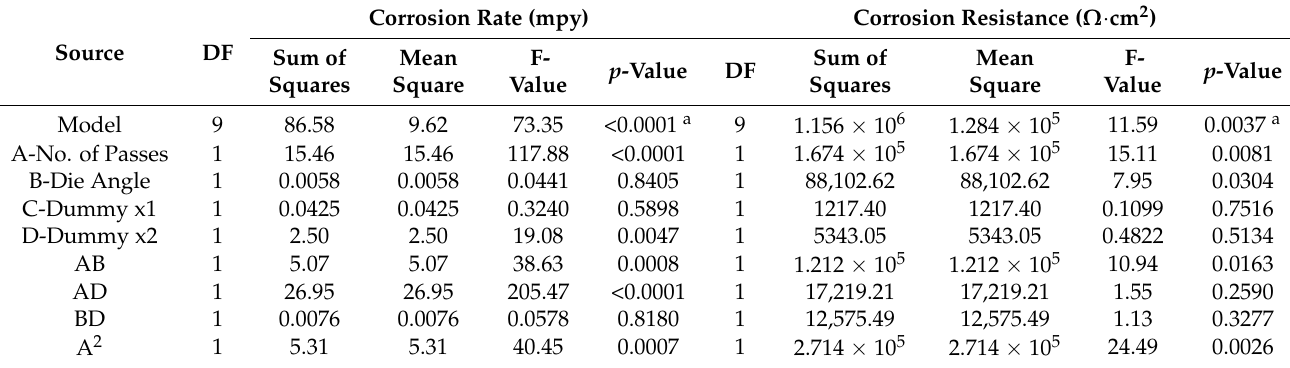
Table A2. Analysis of variance of corrosion rate and corrosion